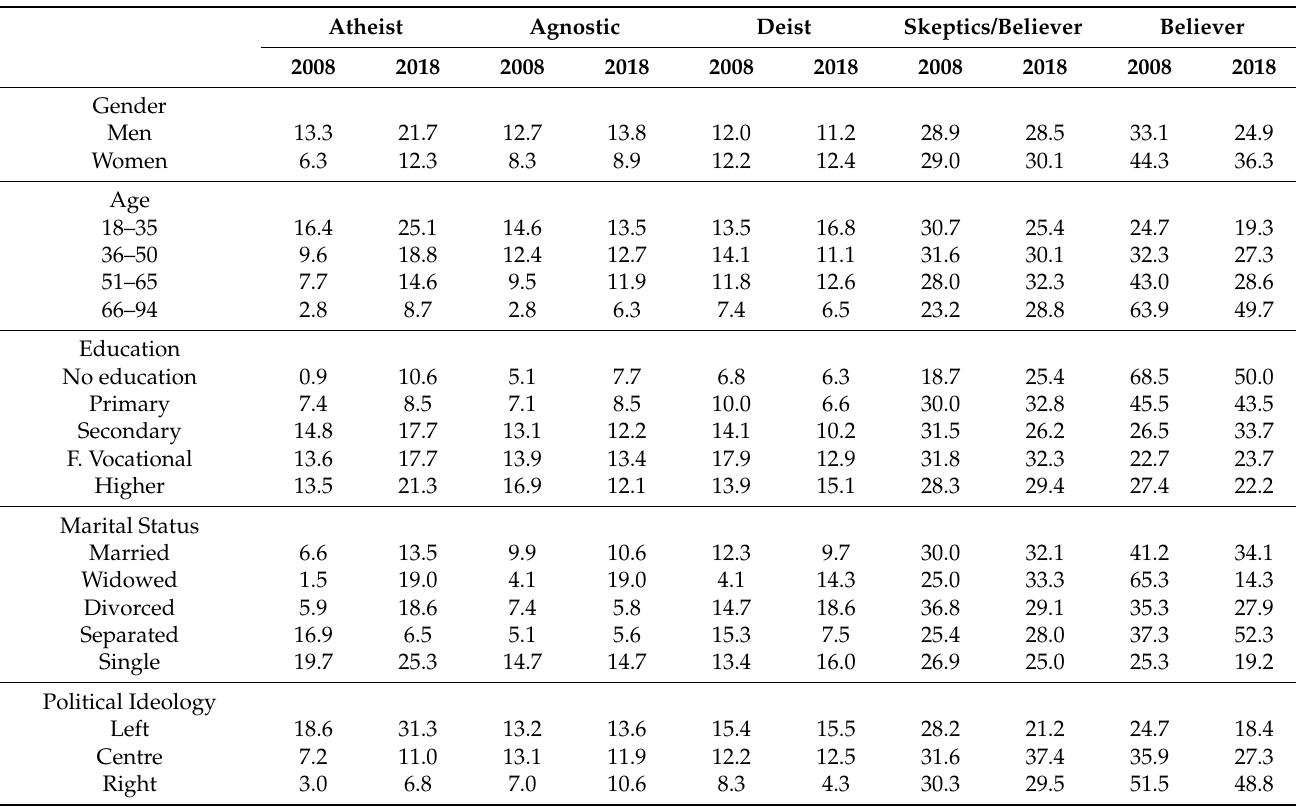
Table A1. Socio-demographic and socio-economic characteristics of Spaniards in 2008 and 2018 (row